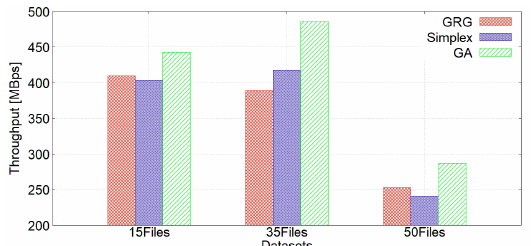
Figure 9. Read throughput using replication factor